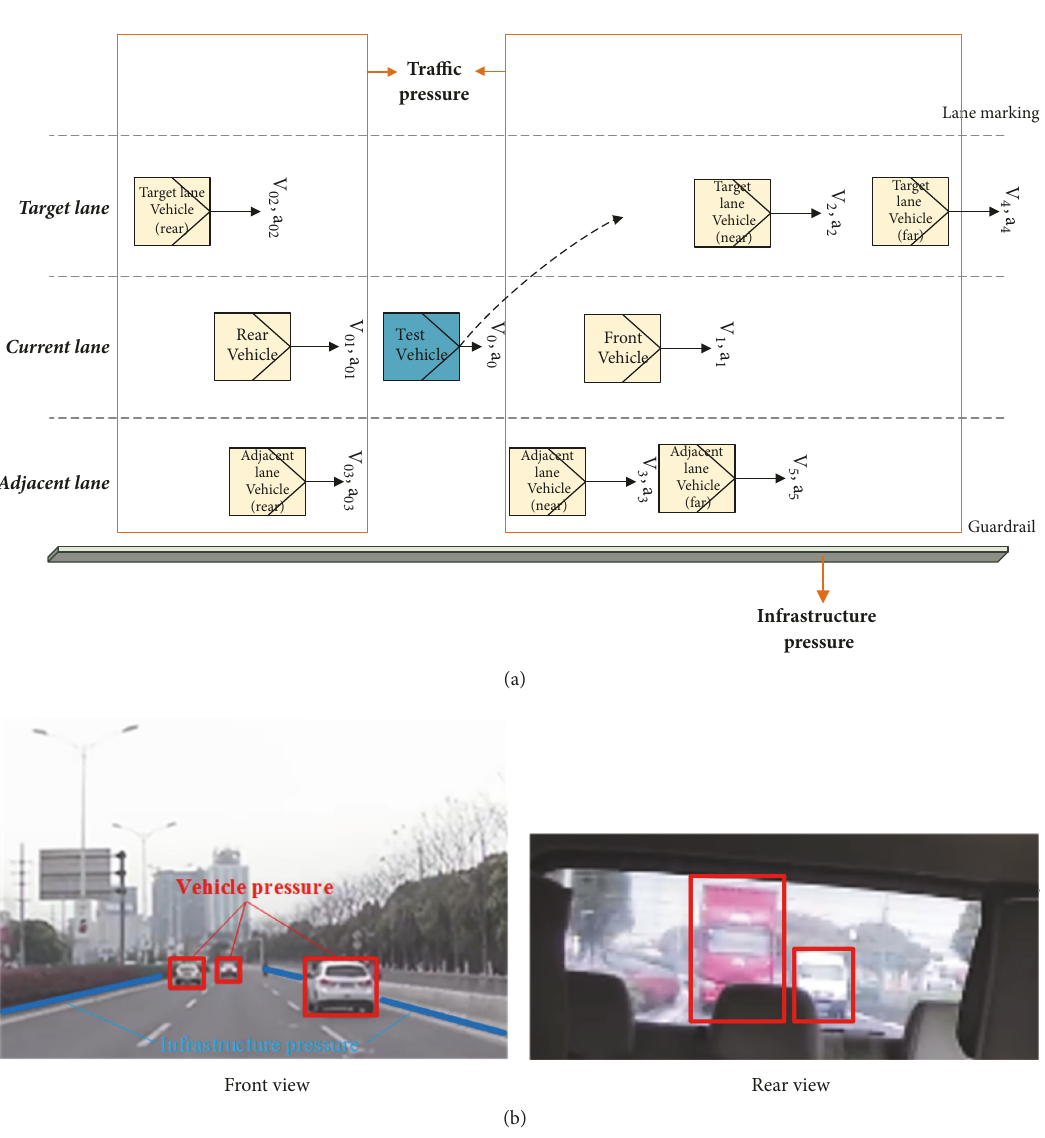
Figure 1: Two sources of traffic environmental vision pressure ((a) top view, (b) first perspective